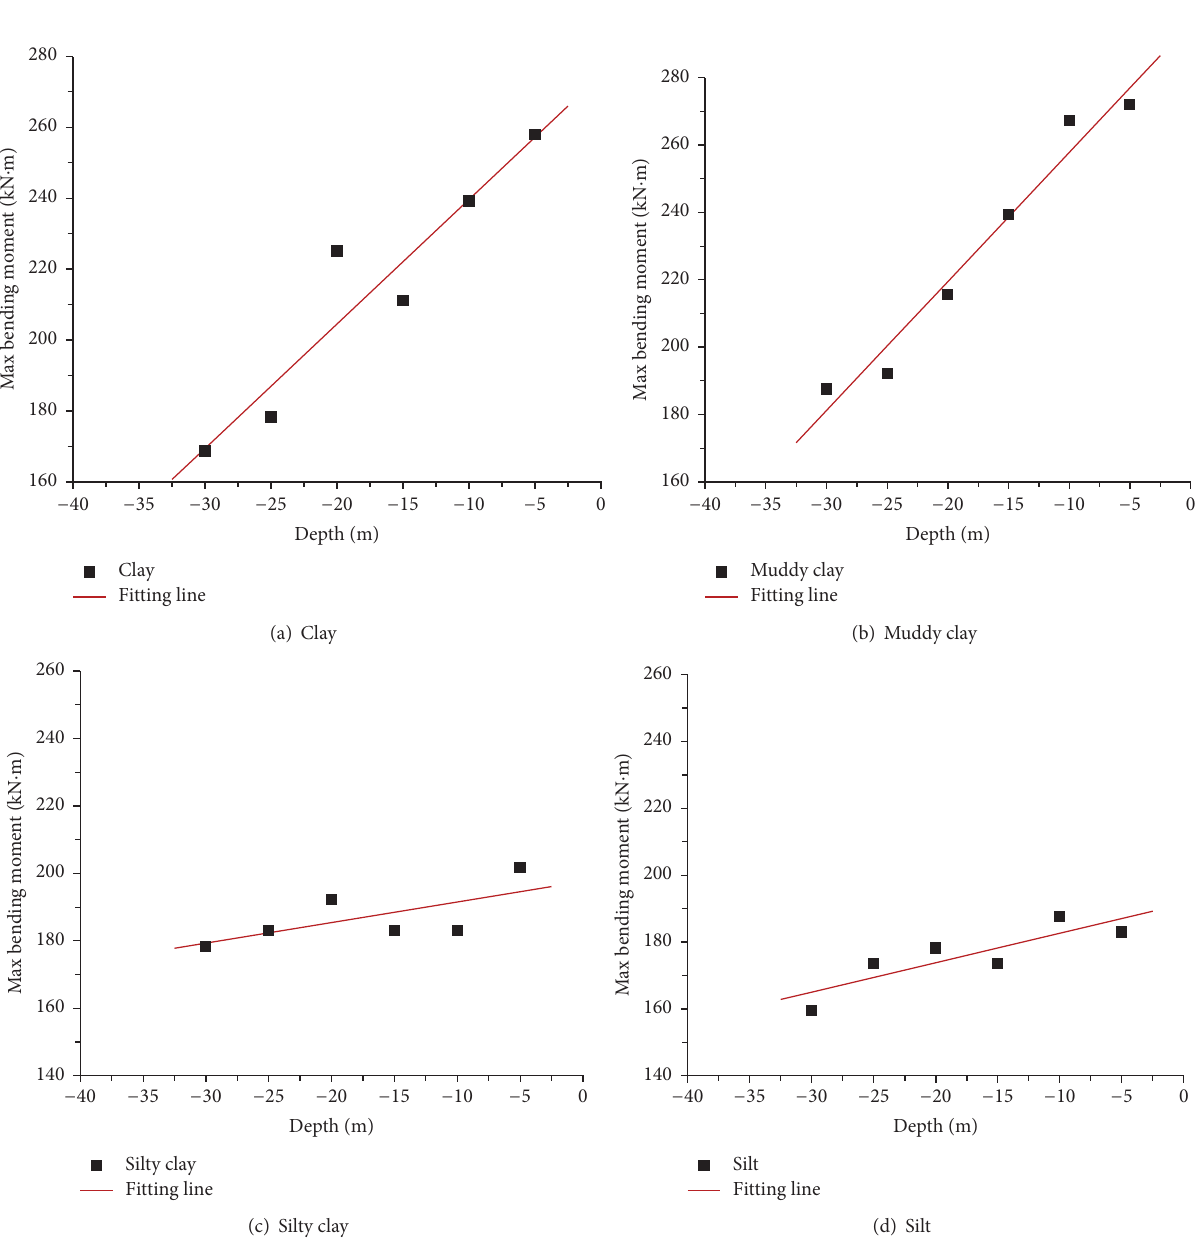
Figure 3: The relationship between depth and maximum bending moment.